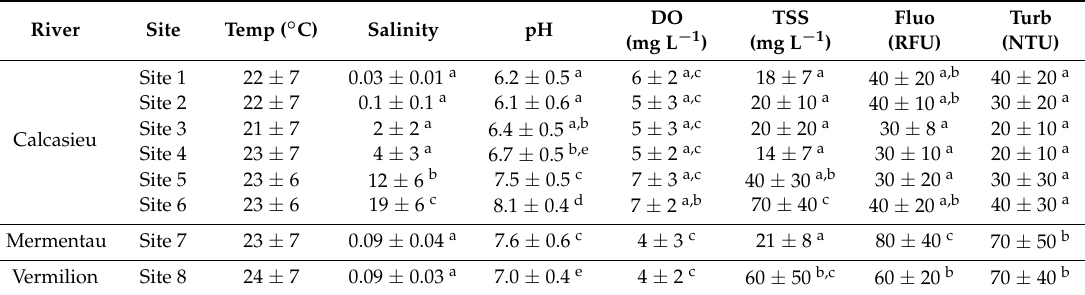
Table 2. Environmental conditions during the study period at six sampling sites along the Calcasieu River entering the Northern Gulf of Mexico in the southern United States. Tukey-Kramer’s adjustment was used to group sampling sites when analysis of variance (ANOVA) shows significant differences among sites. Means with the same superscript letter (a, b, c, d, or e) are not significantly different at